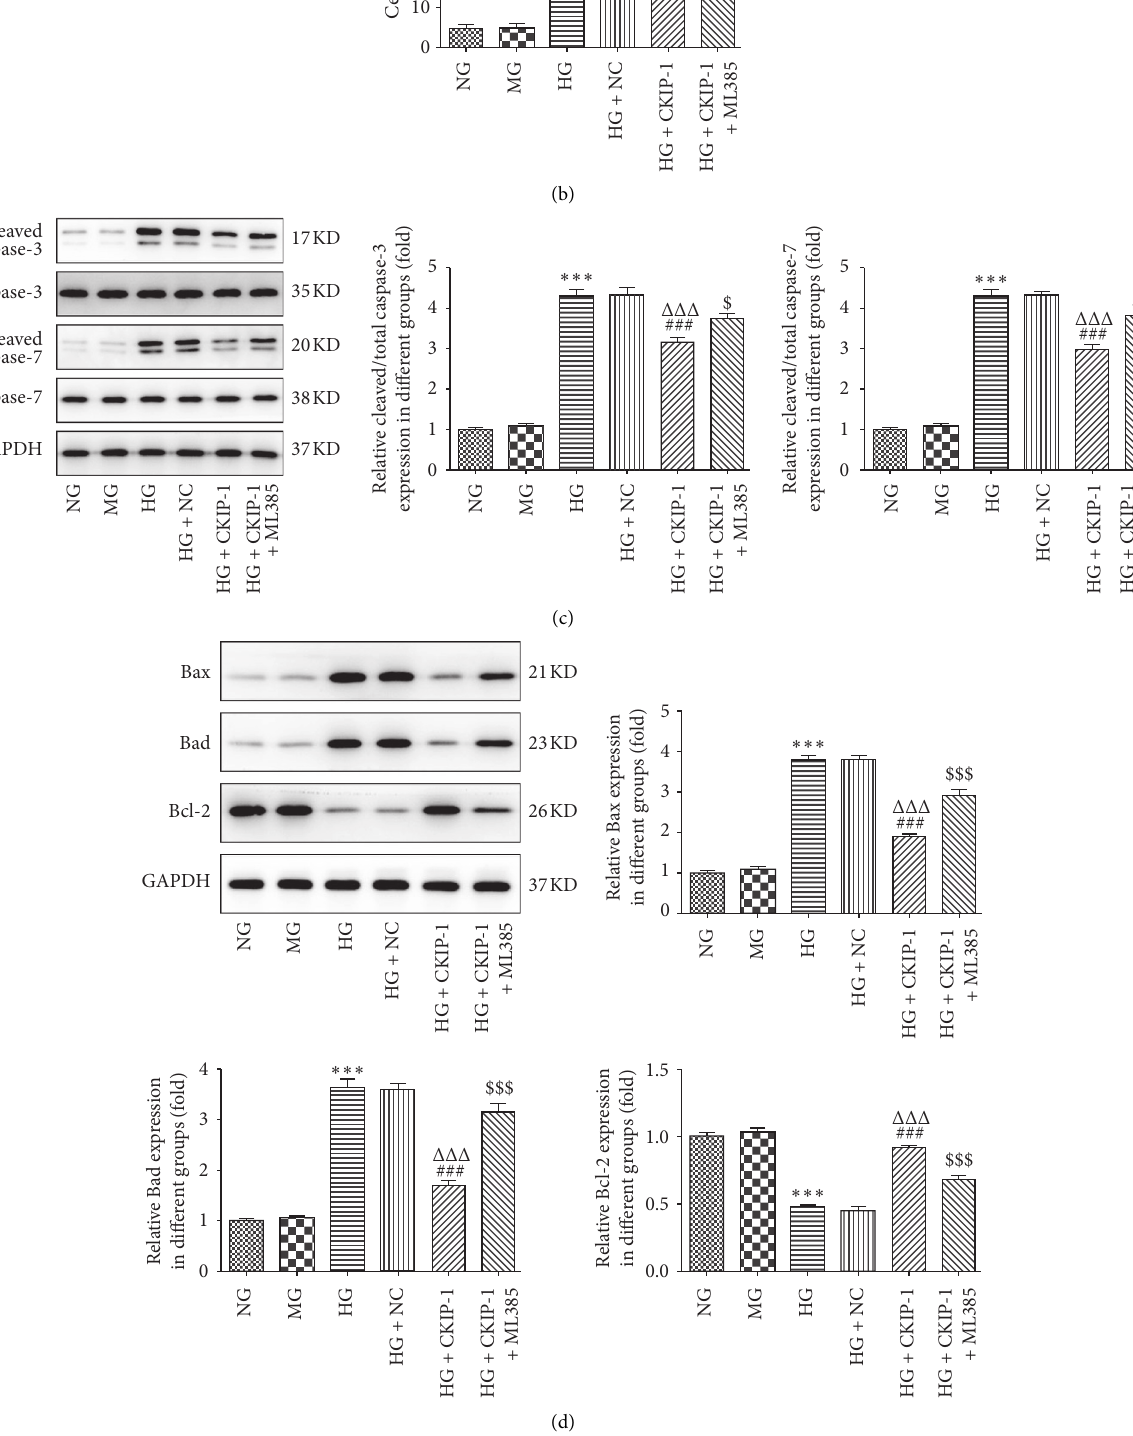
Figure 6: CKIP-1 alleviates apoptosis induced by high glucose. ((a) and (b)) The apoptotic cells were measured by flow cytometry and analyzed by flow Jo. ((c) and (d)) The apoptosis-associated markers were evaluated by Western blot. ∗∗∗ p < 0.001 vs. NG. ### p < 0.001 vs. HG. ΔΔΔ p < 0.001 vs. HG +NC. $ p < 0.05 and $$$ p < 0.001 vs. HG +CKIP-1. NG, normal glucose (5.5mM); MG, mannitol (20mM); HG, high glucose (25 mM); NC, pcDNA3.1 vector negative control; CKIP-1, pcDNA3.1-CKIP-1; ML385 (5 μ M), the Nrf2